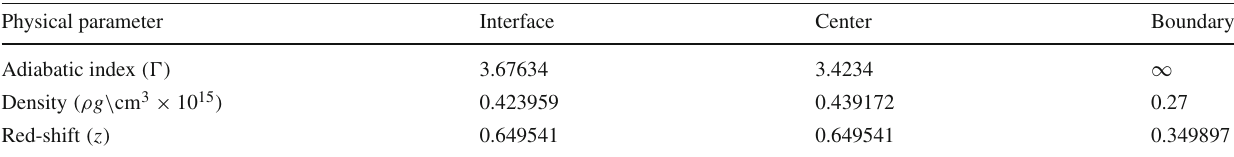
Table 4 Values of physical parameters for star 4 U 1608 − 52 with C = 3 × 10 8 ms − 1 , M = 1 . 85 M (cid:16) , R C = 2 . 459 km, radius R E = 8 . 2 km, G = 6 . 67 × 10 − 11 m 3 kg − 1 s − 2 and M (cid:16) = 2 × 10 30